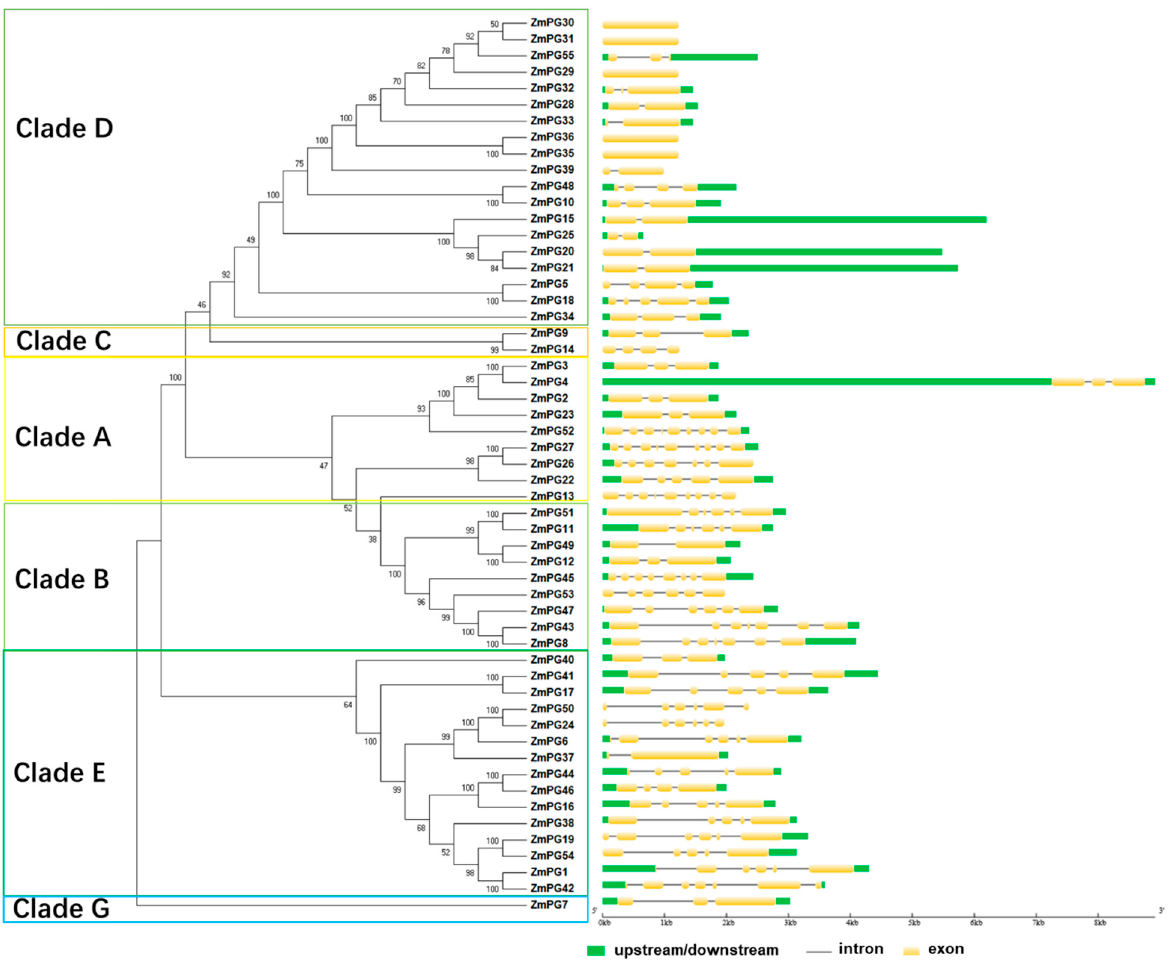
Figure 2. Phylogenetic and gene structure analysis of ZmPG genes. The left panel shows the phylogeny of ZmPG genes. The right panel illustrates the intron/exon configurations of the corresponding ZmPG genes.